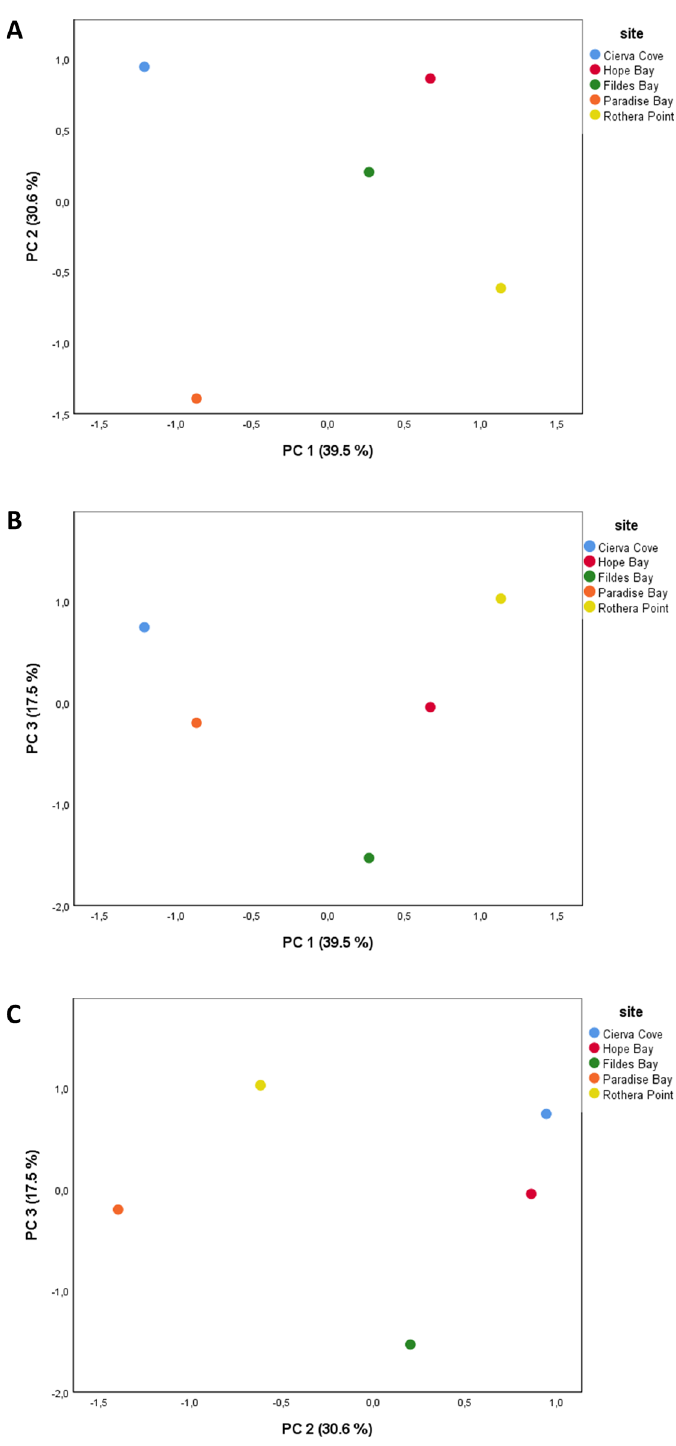
Figure 4. Principal Component Analysis (PCA) score plots. ( A ) PC 1 vs. PC 2. ( B ) PC 1 vs. PC 3. ( C ) PC 2 vs. PC